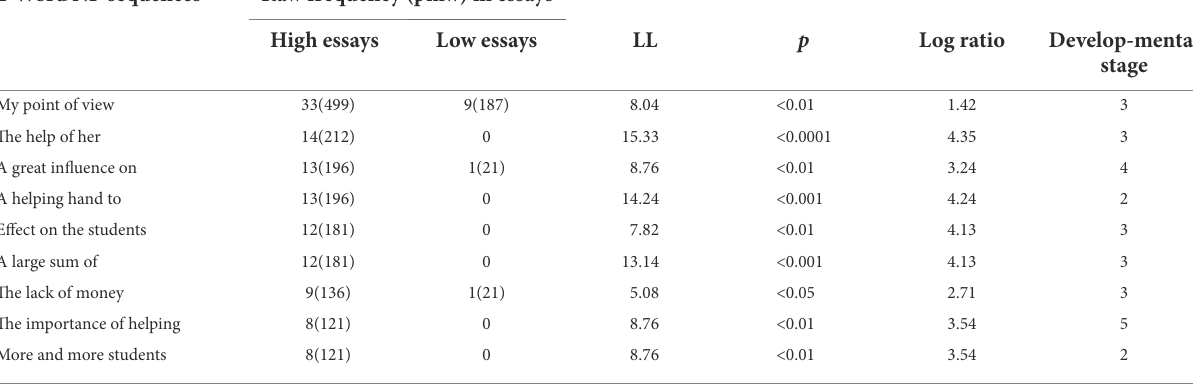
TABLE 6 4-Word NP sequences appearing more in high-rated essays.